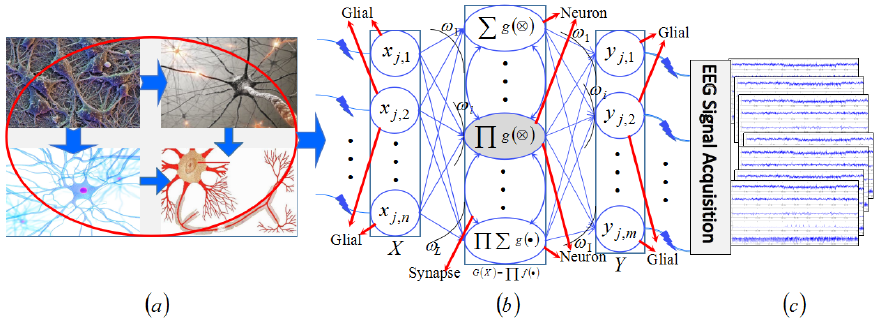
Figure 3. Hypothesis on the work mechanism of brain activity, ( a ) the nerve cells in the brain, ( b ) the structure of brain cells and motivation signals, and ( c ) collected electroencephalographic (EEG)